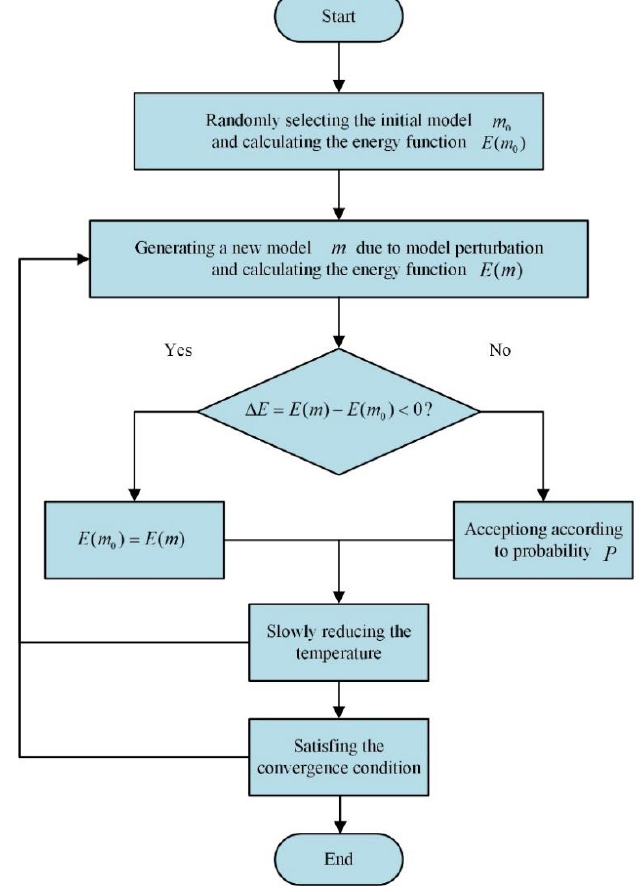
Figure 4. Flow chart of the simulated annealing algorithm.